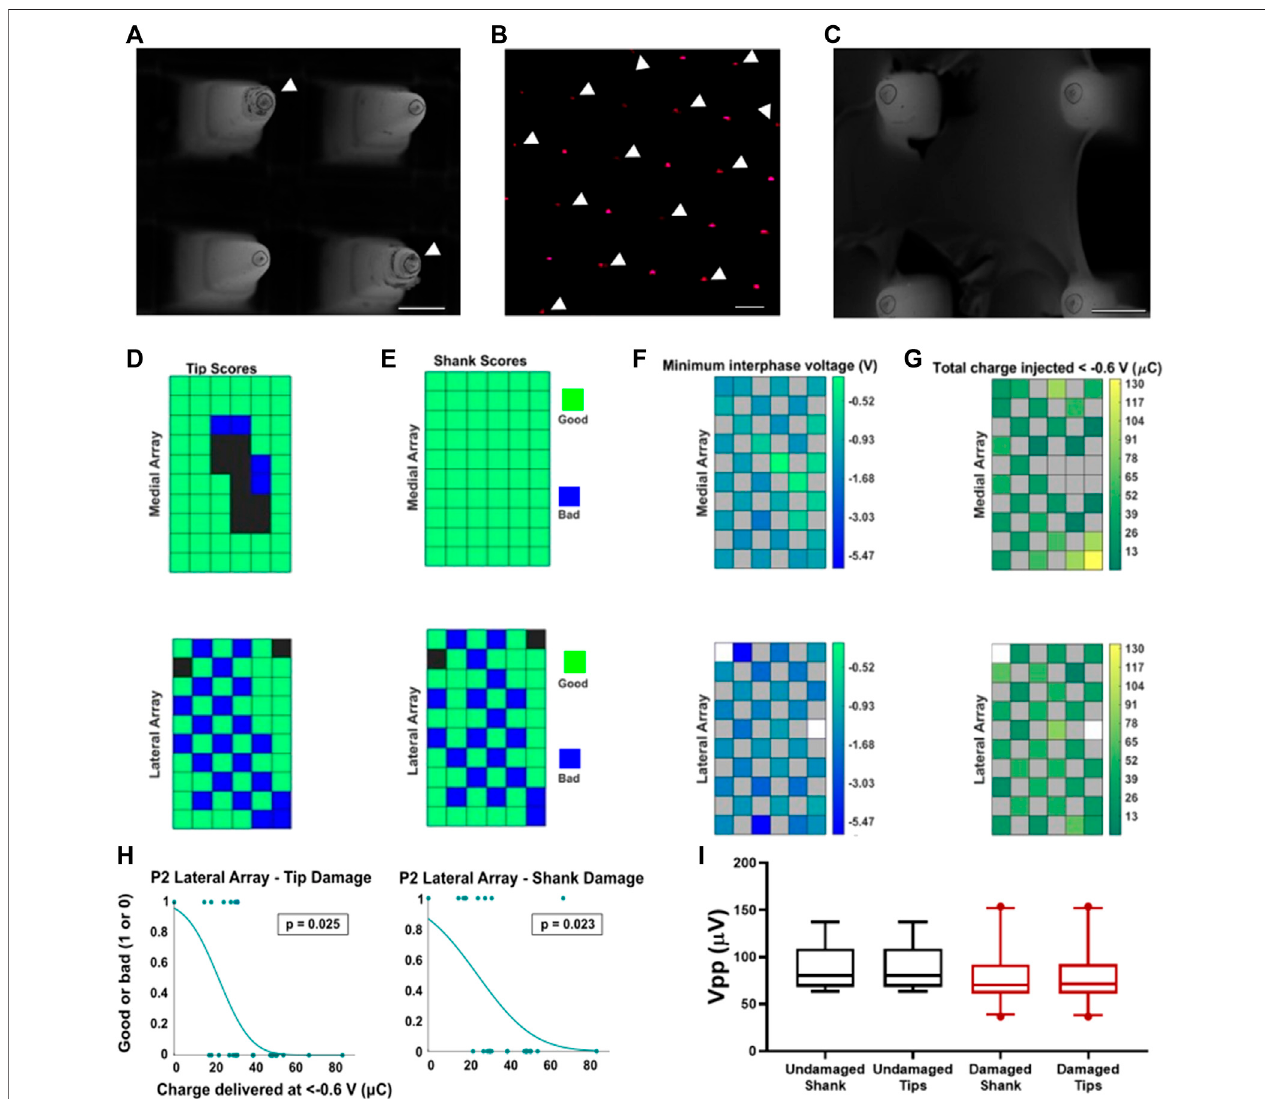
FIGURE7| Stimulation-induced material damage on one of the two arrays. (A) SEM image of four shanks of the lateral array, tip damages are found on the stimulated electrodes marked with white arrows. (B) EDS of the stimulating electrodes for the lateral array showing reduced presence of iridium (magenta) on most of the stimulated sites (white arrows). (C) SEM image of the medial stimulating array tips. No differences were observed between the non-stimulated and stimulated tips on this array. Scale bars are 100 µm. (D,E) Arrays showing the measured material properties on the stimulation arrays including tip categories (D) and shank categories (E) . Green spaces show electrodes categorized as undamaged/unencapsulated, blue spaces show electrodes categorized as damaged, and black spaces show electrodes that were excluded from analysis. (F,G) . Medial (top) and lateral (bottom) stimulating arrays showing (F) minimum interphase voltage (G) and total charge injected below − 0.6 V. The color bar for the minimum interphase voltages is log-transformed to emphasize differences between electrodes. Grey spaces indicate unwired electrodes. White spaces indicate wired electrodes that were never stimulated. (H) Logistic regression for charge injected over − 0.6 V and damage to tips (left) or shanks (right). (I) Measured peak-to-peak voltages on stimulated electrodes after removing electrodes which were encapsulated with fi brous tissues. There were no signi fi cant differences observed in the measured unit amplitudes (Mann- Whitney non-parametric